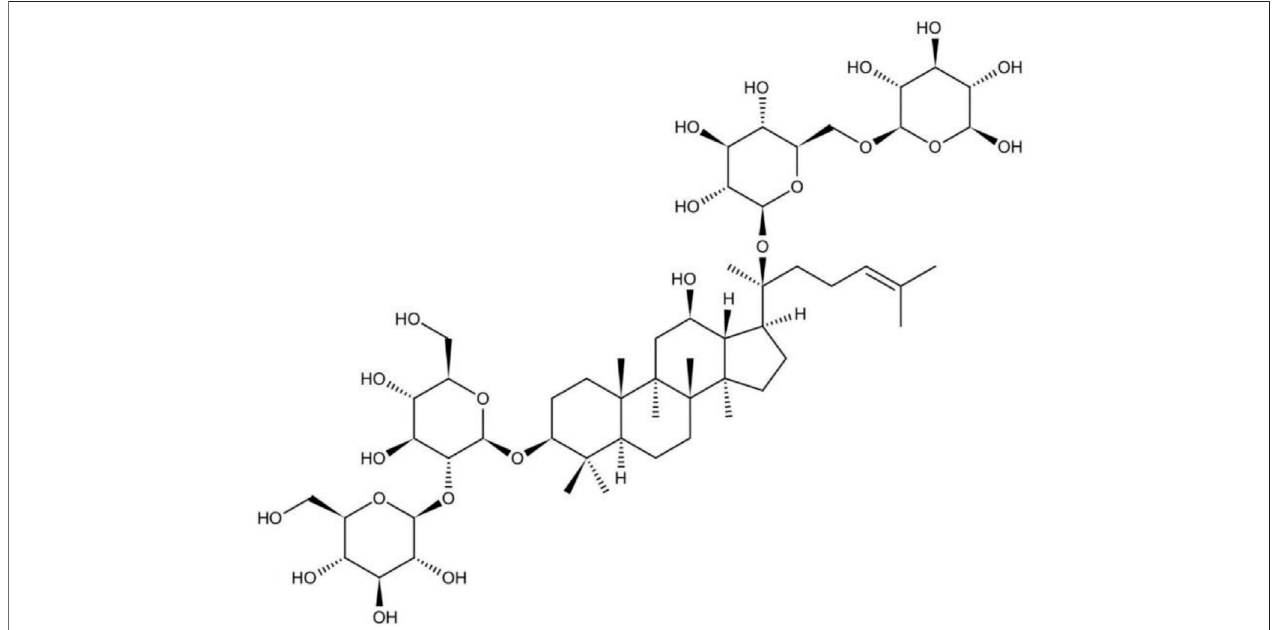
FIGURE 1 | The structure of ginsenoside